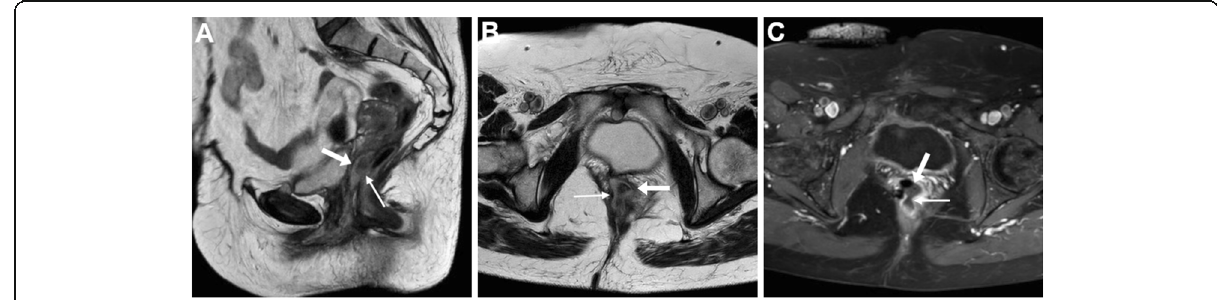
Fig. 6 Recto-VF after surgical treatment of bladder and uterine prolapse with prosthetic mesh placement. T2-weighted ( a , b ) and FS post- gadolinium T1-weighted ( c ) MRI images show wide fluid-filled communication (thin arrows) between the distal rectum and upper third of the vagina (arrows), with marked peripheral enhancement in ( c ). Note poor visualisation of the mesh (few artefacts abutting the right side of the VF on c